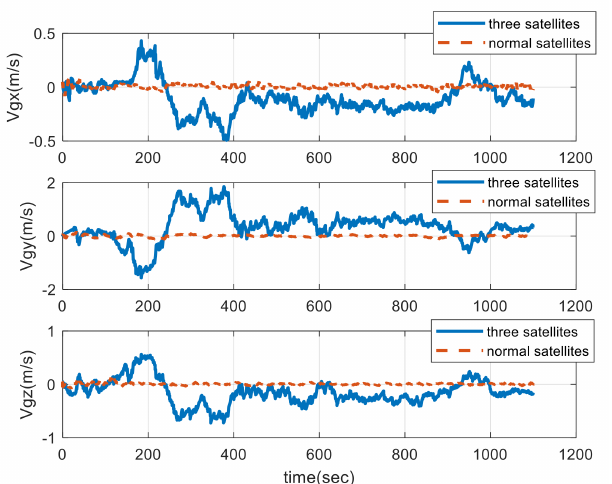
Figure 9. Comparison of velocity errors between normal-number satellites and three satellites.